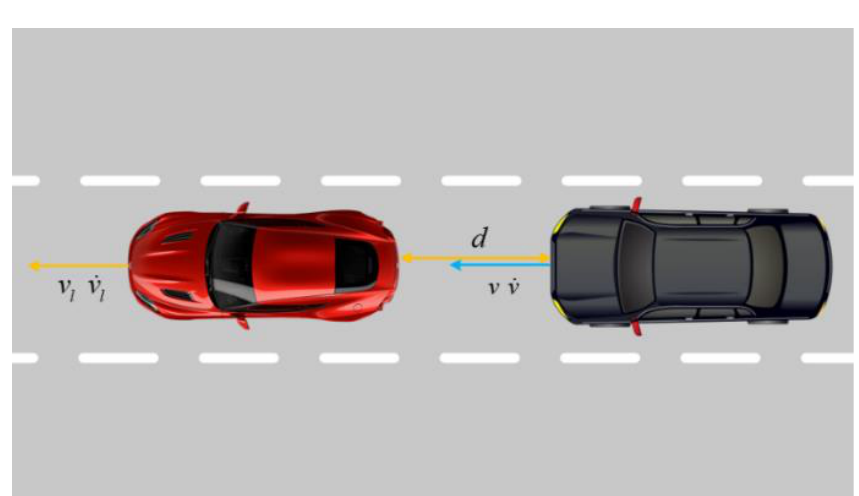
Figure 11. Description of cruise mission status.